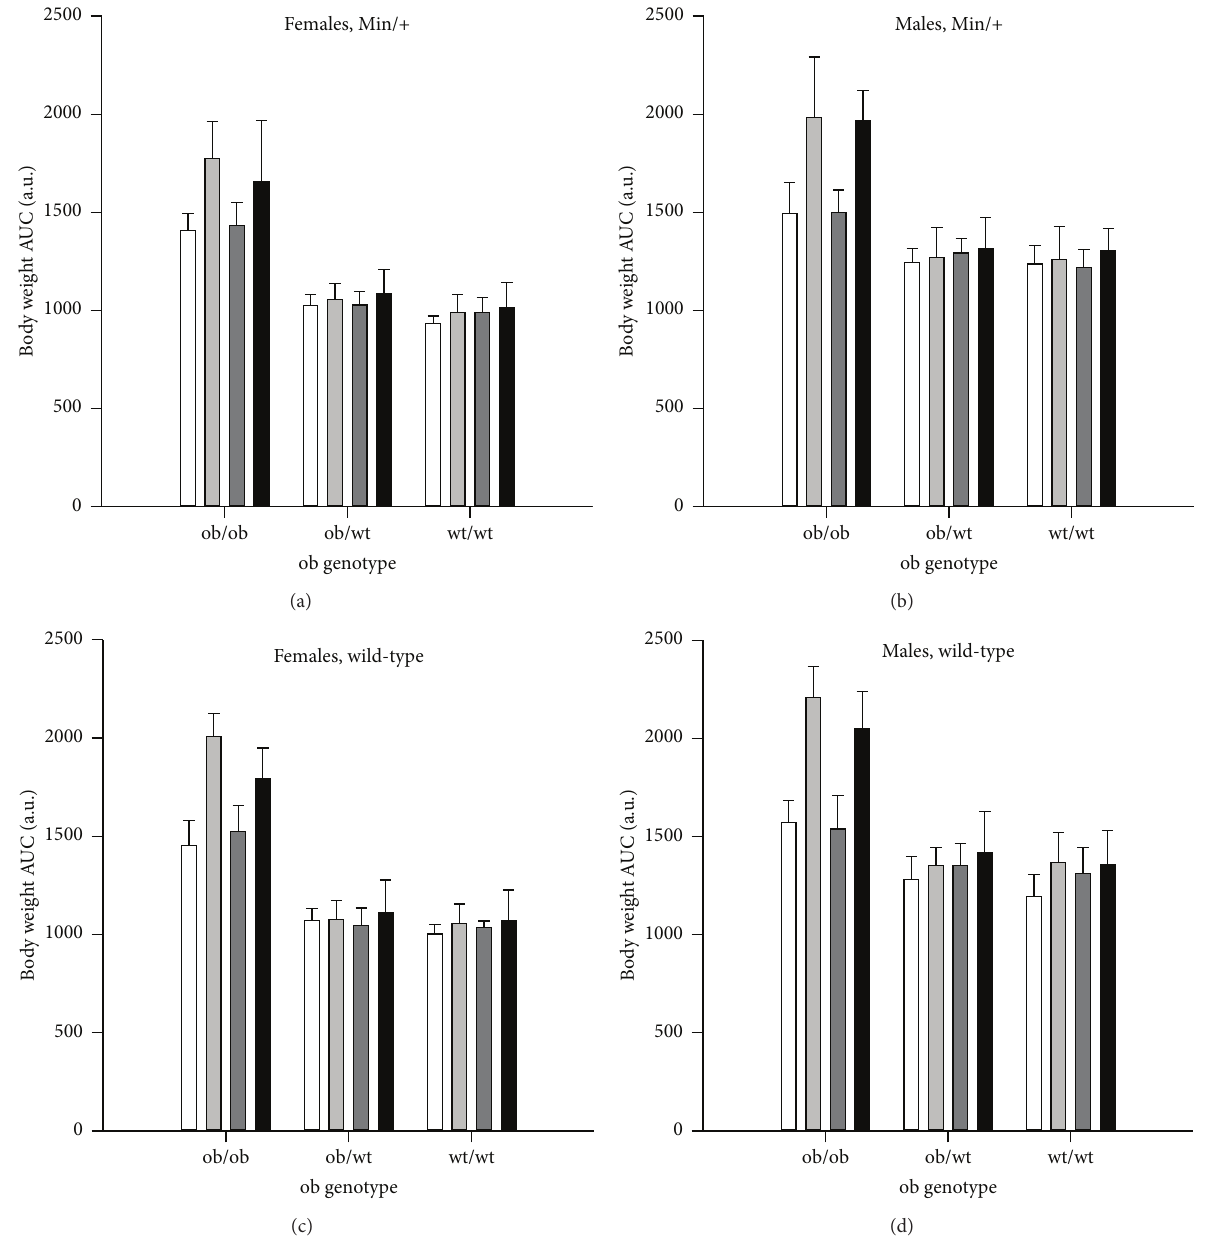
Figure 1: Body weight as area under the curve (AUC). Body weight was recorded weekly from weaning at week 3 until termination at week 11 and is presented for Apc Min/+ (a) females and (b) males, and Apc +/+ (c) females and (d) males (mean ± SD). The mice were exposed to 0.9% NaCl and given a 10% fat diet (white columns) or 0.9% NaCl and a 45% fat diet (light grey columns), or they were exposed to PhIP and given a 10% fat diet (dark grey columns) or PhIP and a 45% fat diet (black columns). 𝑛 = 10 –18 mice. a.u. = arbitrary